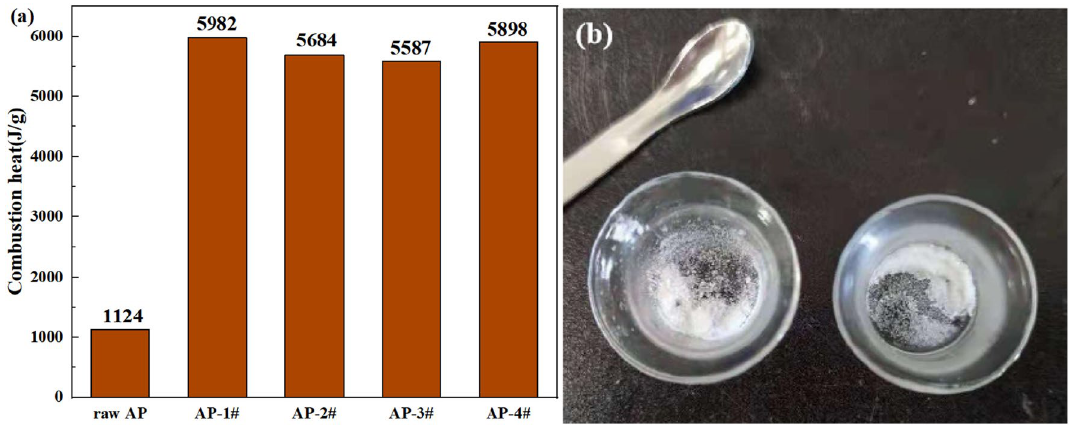
Figure 8. Combustion heat of the sample and incomplete combustion of raw